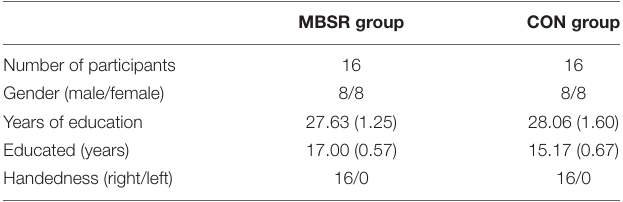
TABLE 1 | Demographic characteristics for all